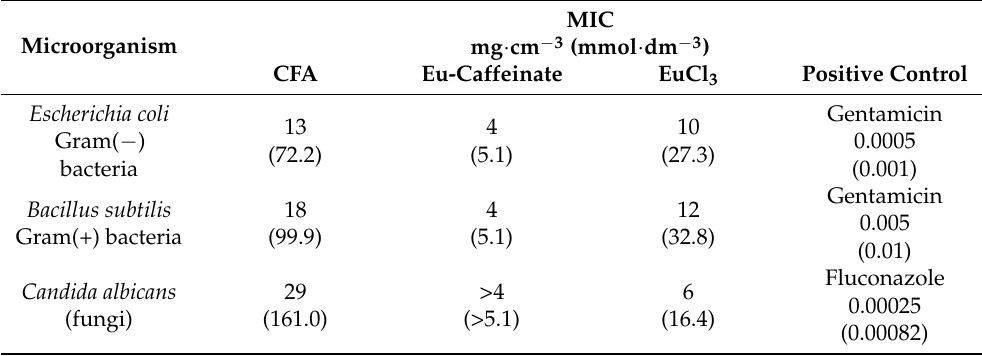
Table 6. The minimum inhibitory concentration (MIC) values for tested compounds against se- lected